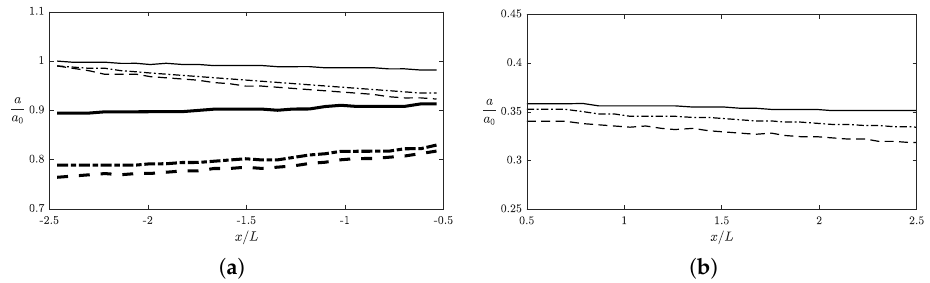
Figure 9. Wave components corresponding to the amplitude variation shown in Figure 8: ( a ) incident waves (thin lines) and reflected components (thick lines); ( b ) transmitted waves. Solid lines: d m = 0 (solid bottom). Dashed lines: d m = δ m . Dashed-dotted lines: d m = 3 δ m . See Figure 8 for the model inputs.